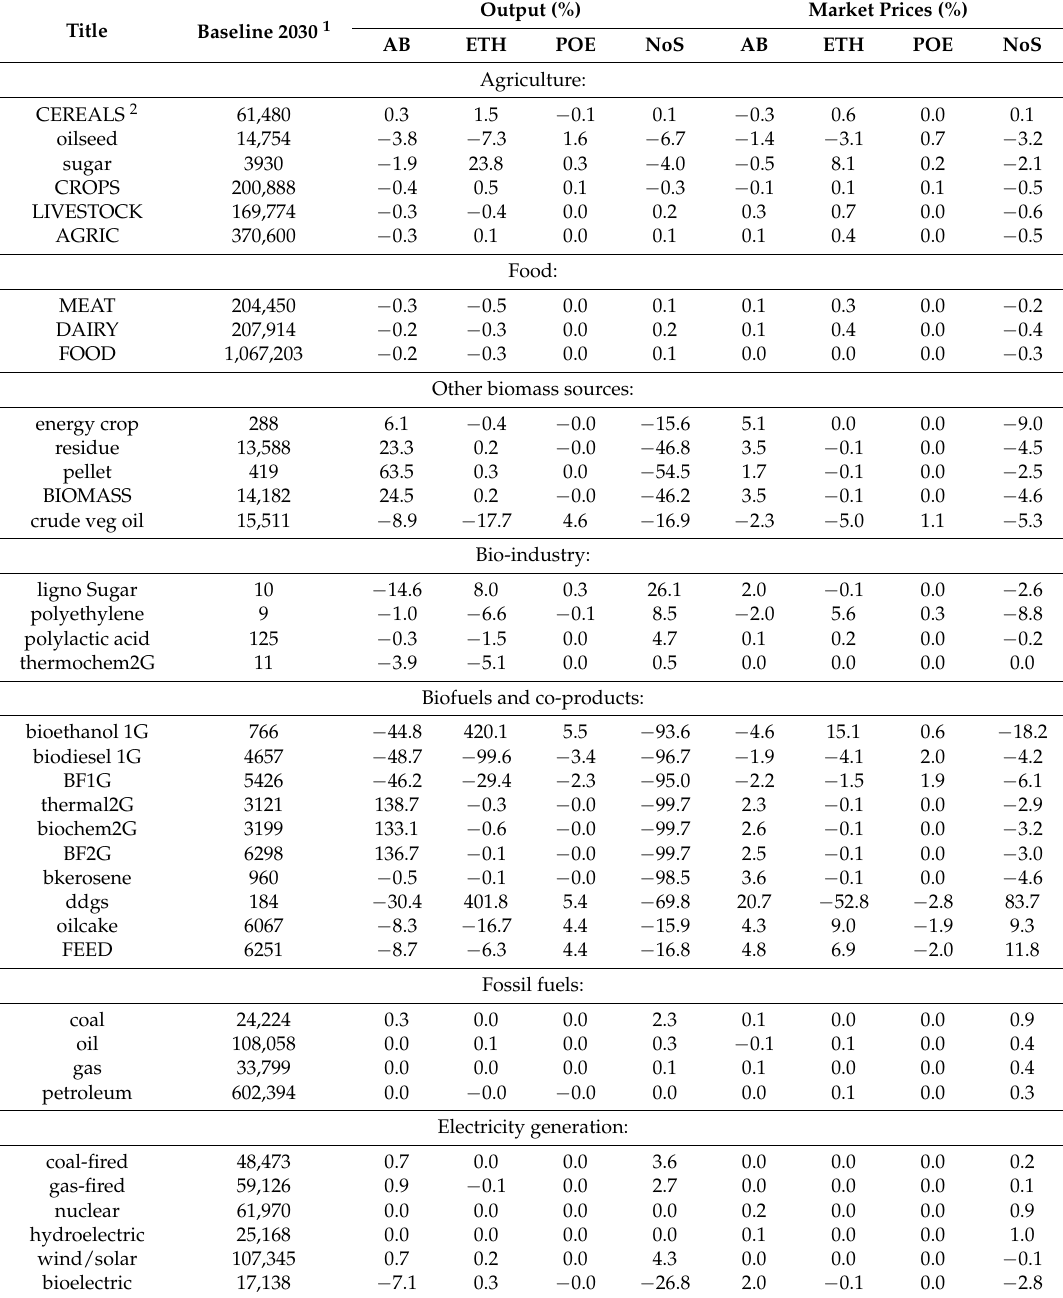
Table 6. EU28 market impacts in bio-based and energy sectors vs baseline